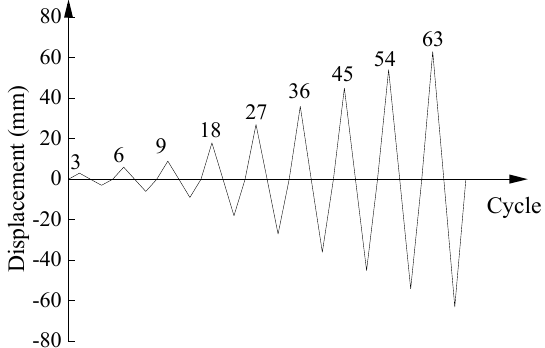
Figure 6. Illustration and photographs of the experimental setup: ( a ) illustration of the experimental setup; ( b ) photographs of the experimental setup.